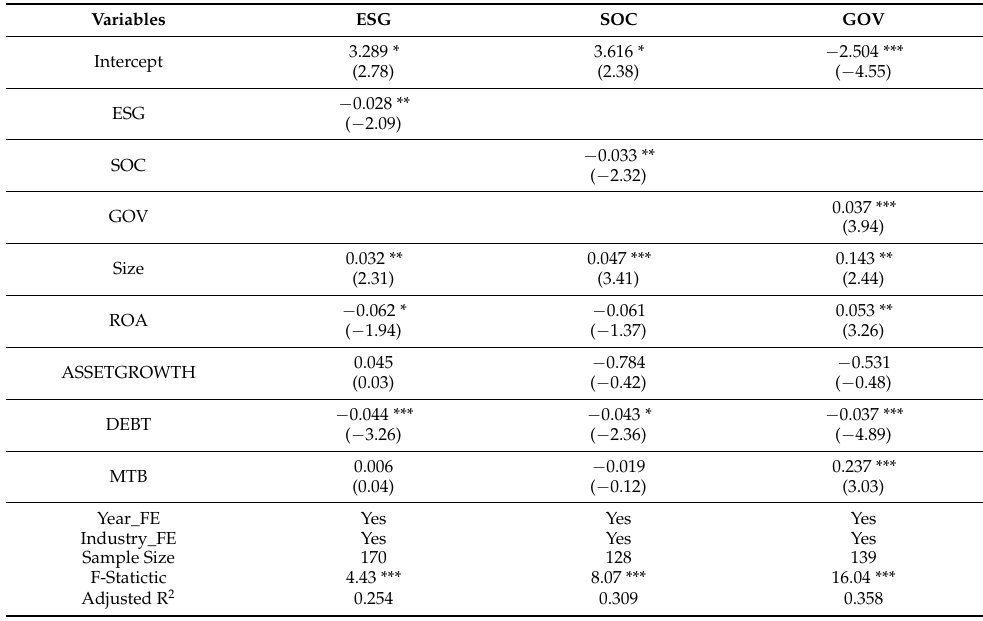
Table 6. The impact of environmental, social, and corporate governance (ESG), social (SOC) and governance (GOV) disclosures on stock